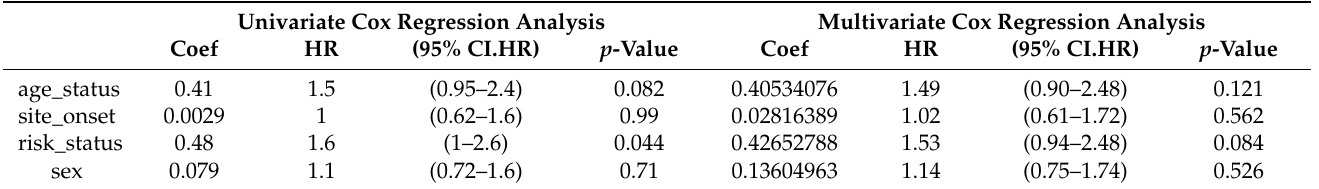
Table 3. Univariate Cox regression analysis and multivariate Cox regression analysis on the validation